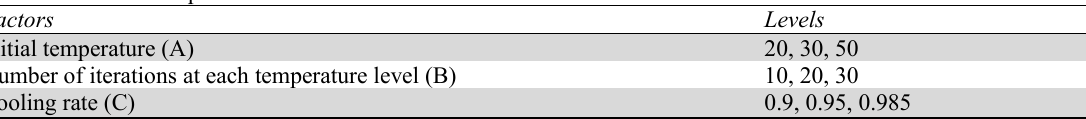
SA-based matheuristic parameter